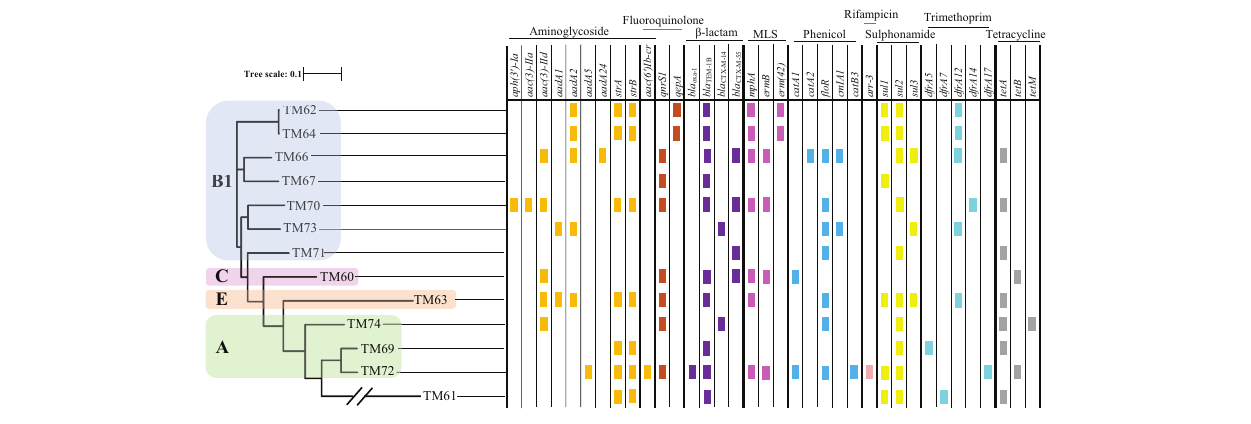
FIGURE 3 | Phylogenetic relationship and distribution of different resistance genes among MCRPEn isolates. Based on single nucleotide polymorphisms, the 13 E. coli MCRPEn isolates were classified into four different phylogroups (A, B1, C, and E) as represented by differently colored boxes over the phylogenetic tree. The presence of different resistance genes that confer resistance toward each of the antimicrobials determined by WGS are shown as small colored rectangles. The two diagonal bars across a branch of the phylogenetic tree represent scale break. MLS, macrolide, lincosamide, and streptogramin B.